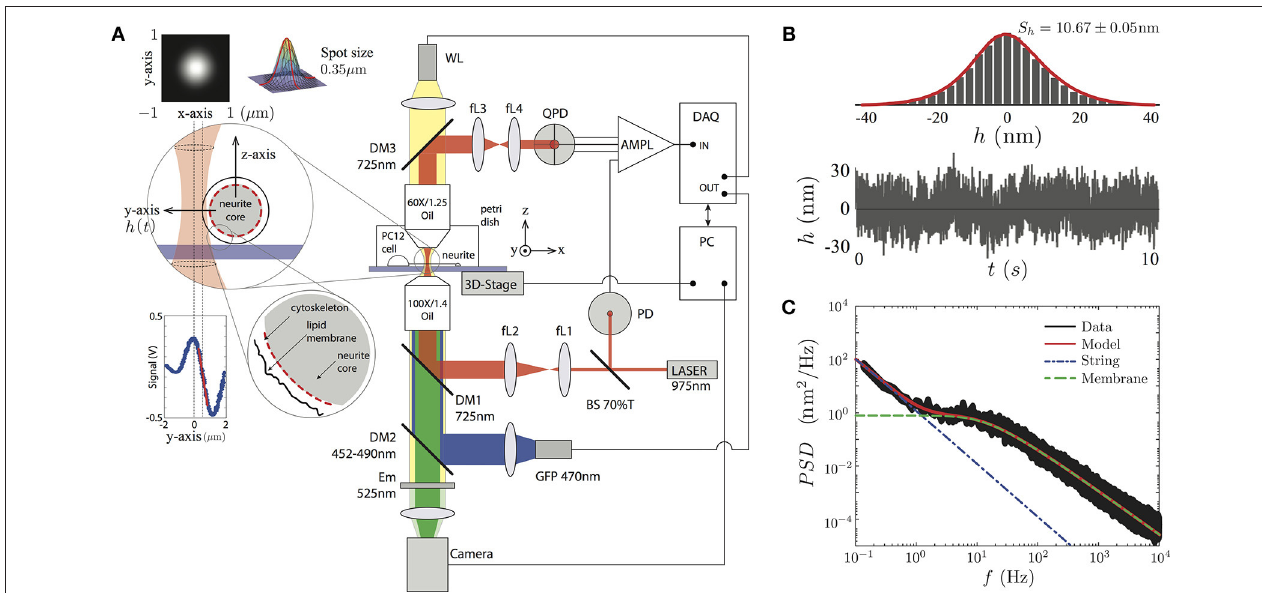
FIGURE 2 | (A) Sketch of the experimental setup. The PC12 neurites are imaged by a white lamp (WL) placed at the top of the setup or by the fluorescent lamp (LED) placed after the IR laser. The PC12 neurite edge is placed near the highly focused laser (less than 10mW). The light scattered by the neurite edge is imaged on a QPD sensor, amplified and recorded by the DAQ card. The conversion from voltages to displacements at the QPD sensor is performed using the slope of the signal in the linear region (red segment at the Signal vs. Position inset plot). The whole system is supported by a passive vibration-damping optical table. (B) The temporal transverse amplitude fluctuation, h ( t ), is acquired during 10 s, displays a Gaussian probability amplitude distribution of a particular PC12 neurite. (C) The PSD is obtained over four decades in the frequency space. The full model (red continuous line), the string (blue point-segmented line), and the membrane (green segmented line) models are shown to be in a complete agreement with the experimental